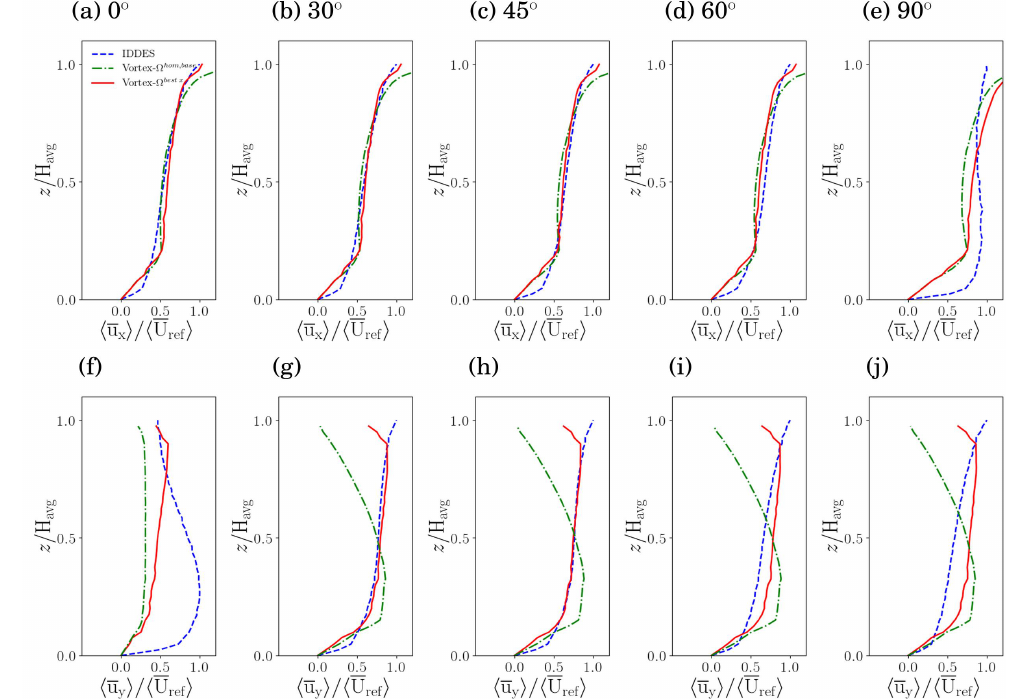
Figure 13. Vertical profiles of mean normalised velocities within the homogeneous domain. ( Top ) u x estimated by Ω bestx (solid red line) and Ω hom , base (dash-dotted green line); ( bottom ) u y estimated by Ω besty (solid red line) and a single vortex sheet ( Ω worsty ; dash-dotted green line). The IDDES profiles are plotted with a dashed blue line. The reference value, the IDDES streamwise velocity at z / H avg = 1. Geometric constants were calculated at